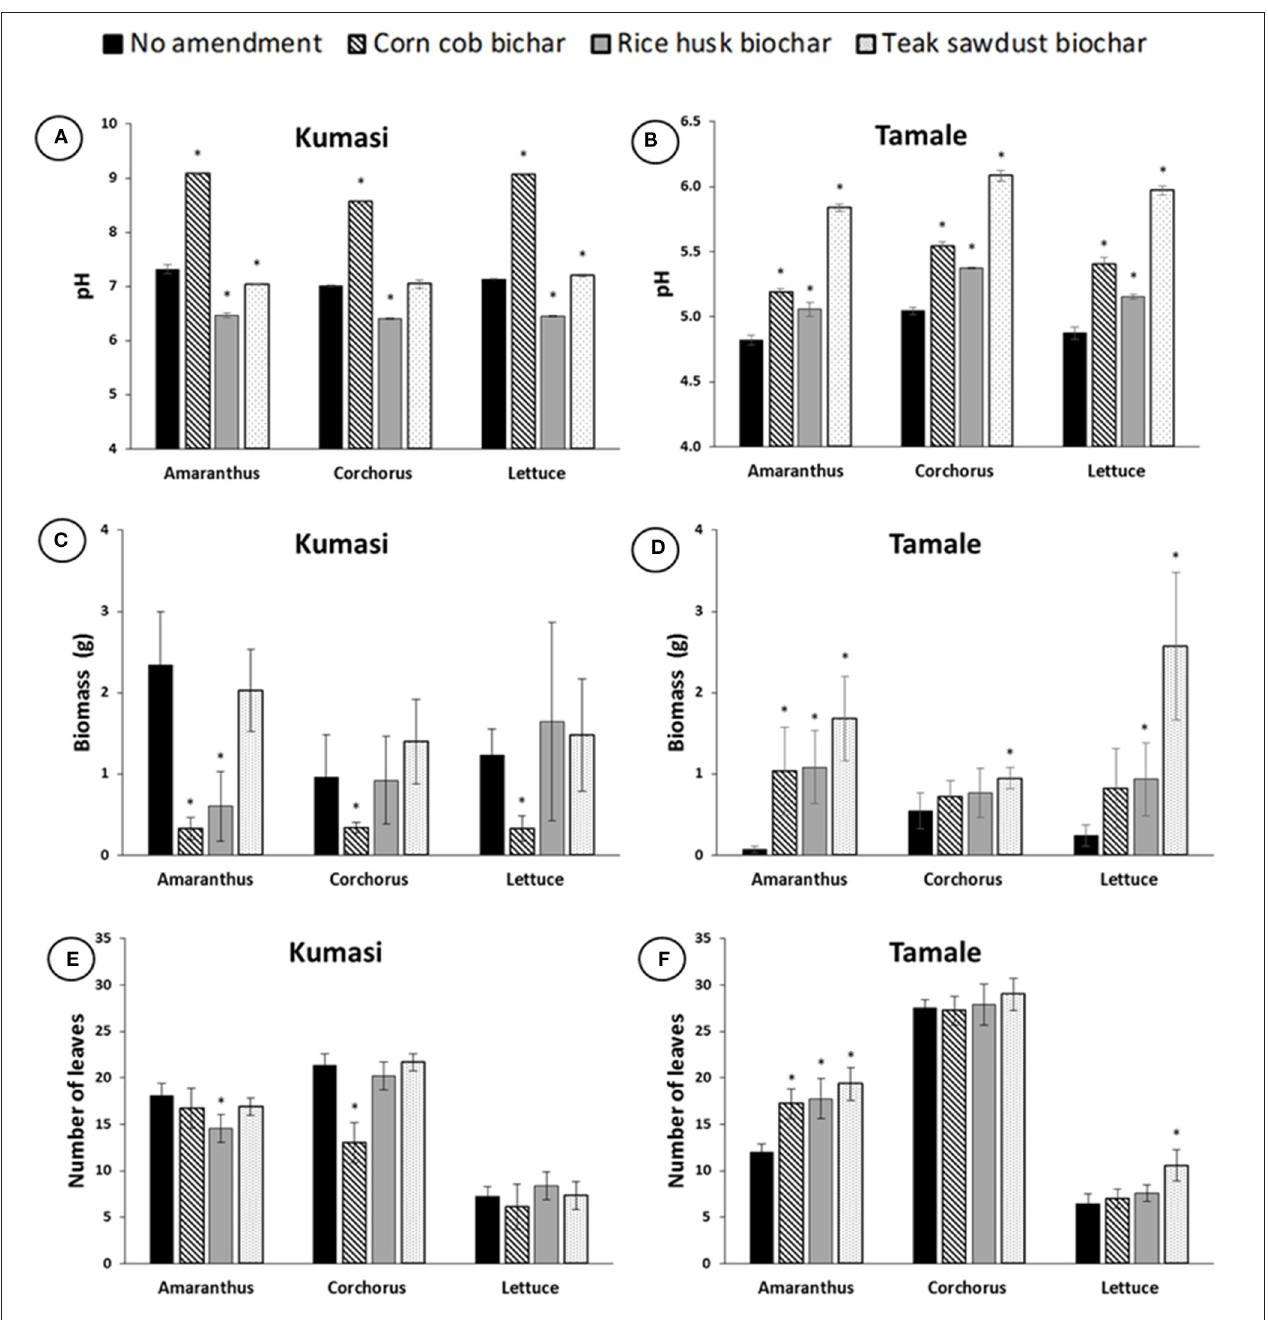
FIGURE 4 | Soil pH, leaf biomass per pot, and number of leaves per pot 4 weeks after planting, for Amaranth, Corchorus, and Lettuce grown in Kumasi (A,C,E) and Tamale (B,D,F) soils amended with 5% (w/w) corn cob biochar, rice husk biochar, or teak sawdust biochar. There was one plant per pot in the greenhouse experiments ( n = 9). Data with asterisks are statistically significantly different from control for each crop ( p < 0.05). Error bars represent standard deviation n = 3.